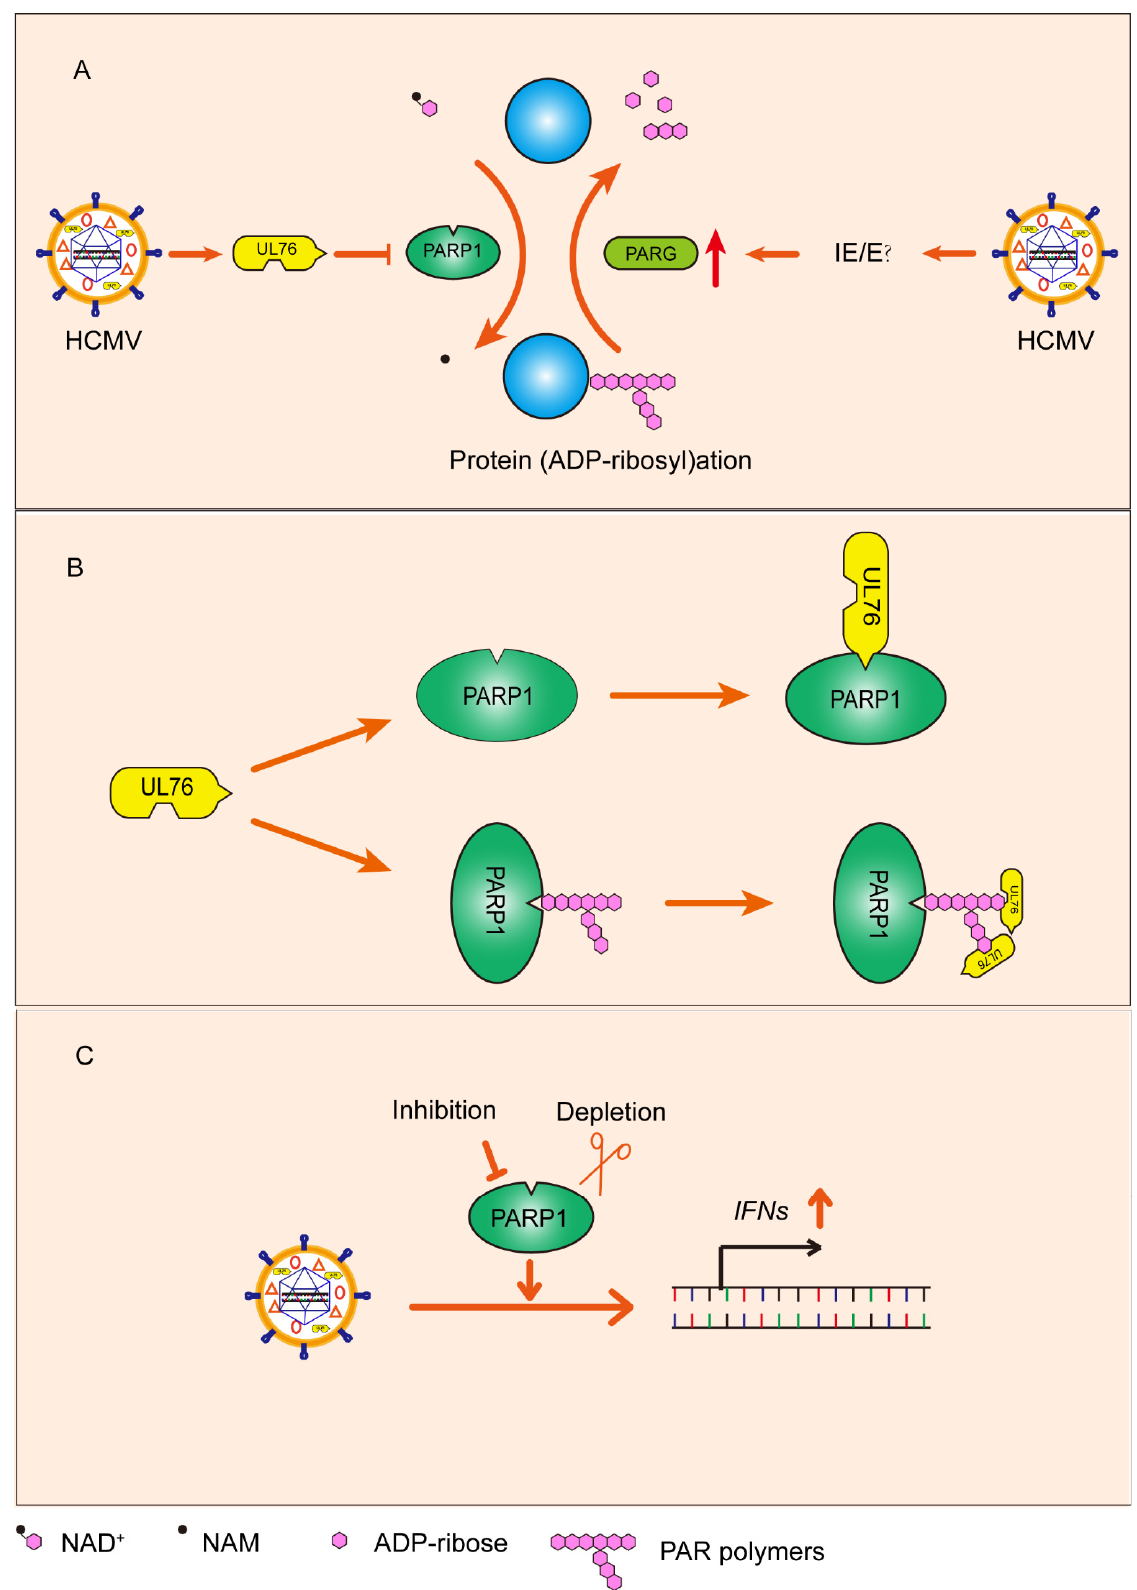
Figure 9. Simplified model summarizing the major findings from the present study. ( A ) HCMV UL76 combined with the infection induced PARG upregulation to manipulate protein PARylation in infected cells. ( B ) Under quiescent state, HCMV tegument protein UL76 bound to the BRCT